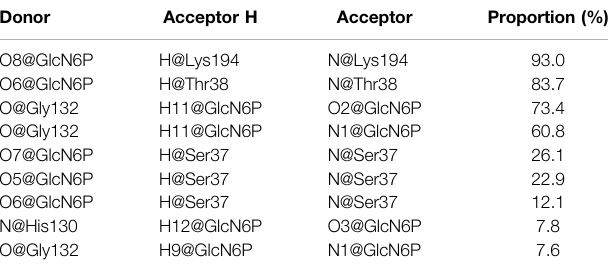
TABLE 1 | Hydrogen bonds formed between Smu NagB-GlcN6P with the corresponding proportion from the fi nal 10 ns trajectory in MD simulations.